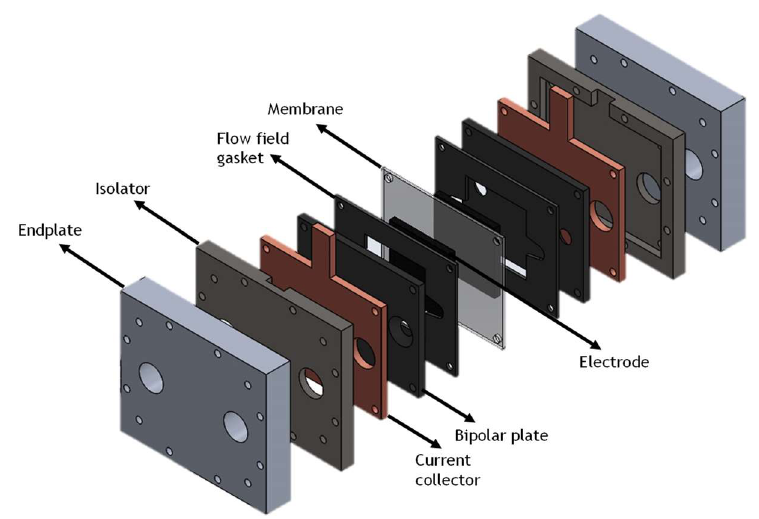
Figure 2. Components of an RFB’s